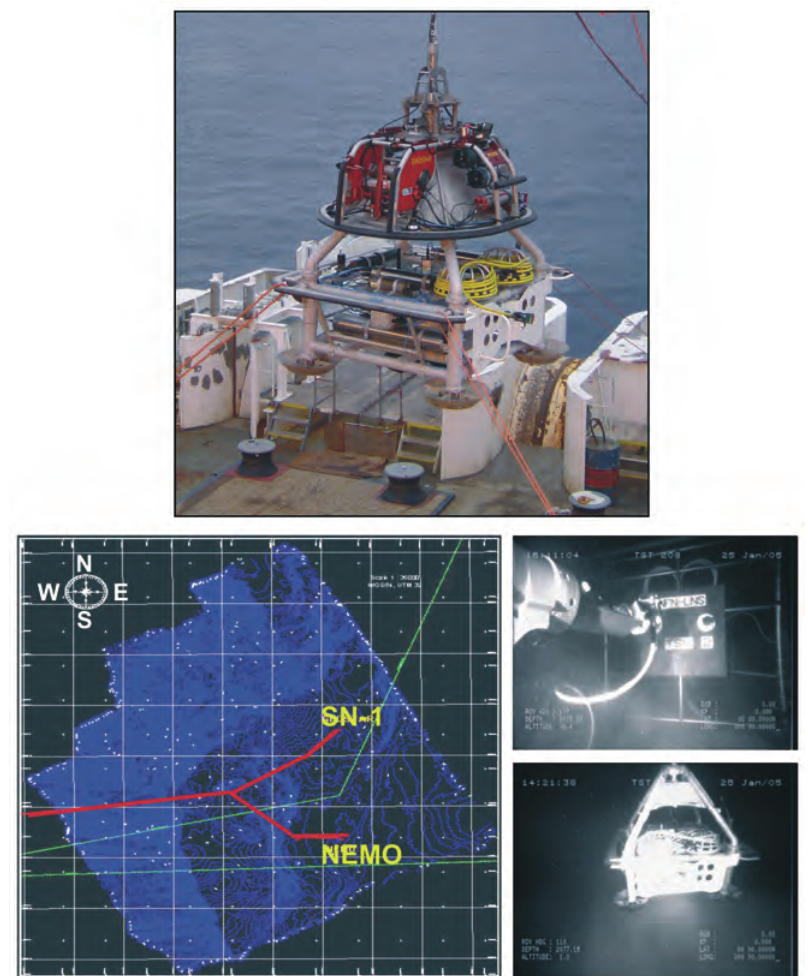
Fig. 6. SN-1 and MODUS ( left ) on the deck of the cable-vessel Pertinacia before deployment; the ROV connect- ing SN-1 Observatory to the cable interface ( top-right ); SN-1 on the seafloor during the cable connecting operations ( bottom-right ). The cable route from Catania harbour to 25-km east in the Ionian Sea is shown in top-left